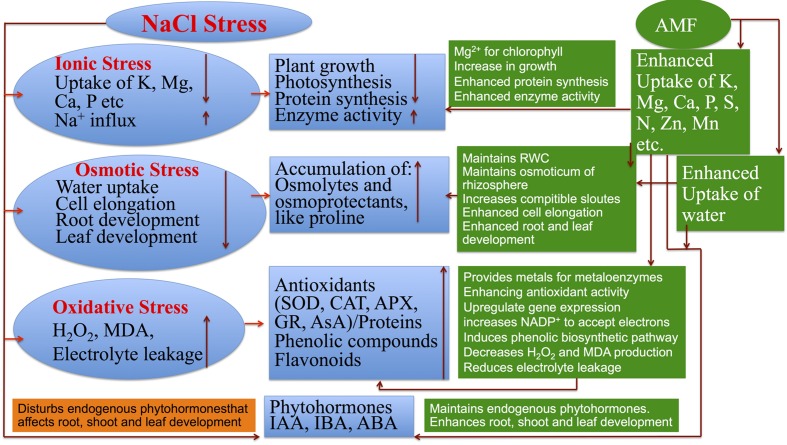
Negative effects of NaCl stress and the mitigating role of AMF in plants.